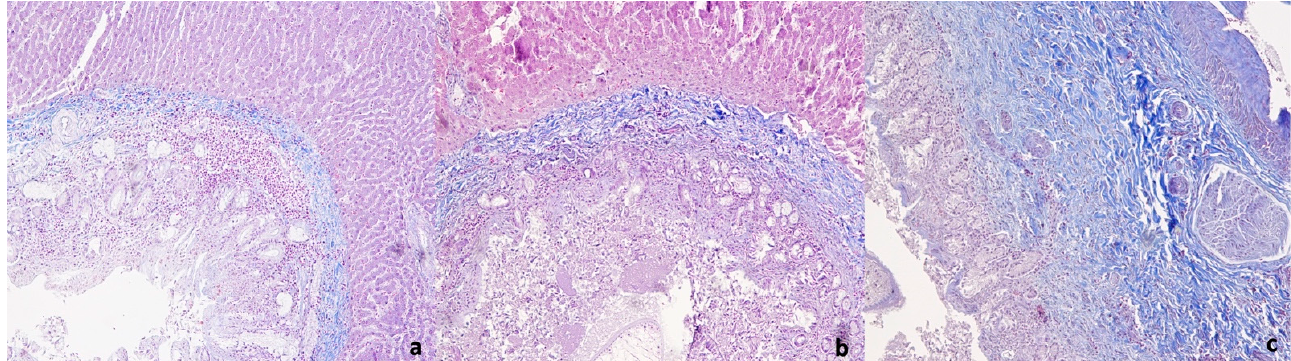
Figure 1. Representative sections from the liver tissues of sheep ( a ): Liver section from sheep of Group A (<30 egg per gram (EPG)) showing mild fibrosis and severe leukocyte infiltration; ( b ): liver section from sheep of Group B showing moderate fibrosis and leukocyte infiltration around the bile ducts; ( c ): liver section from sheep of the Group C showing severe fibrosis around the bile ducts and mild leukocyte infiltration. Masson’s trichrome (original magnification 100×).